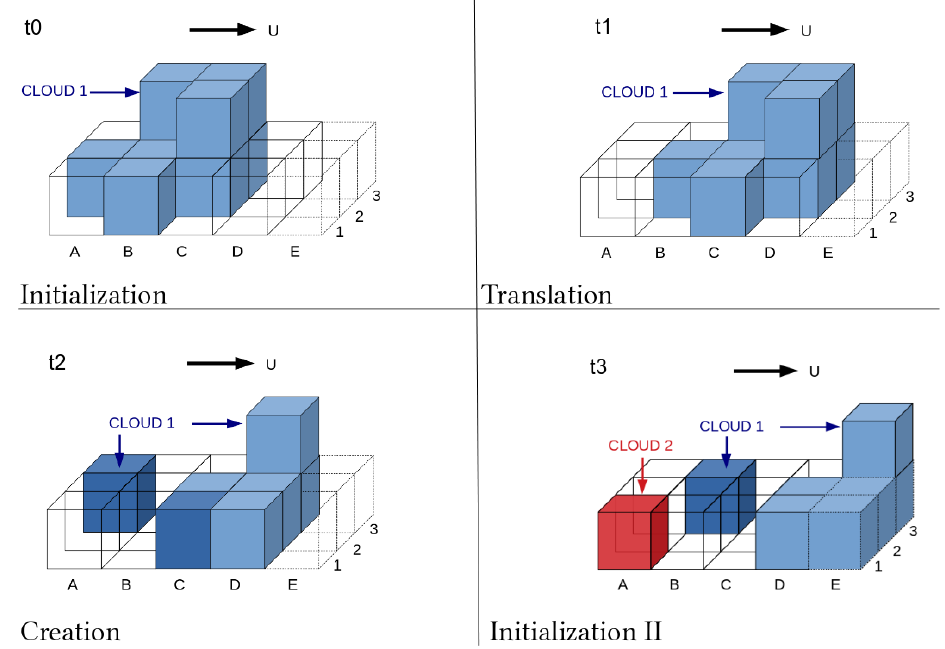
Figure 2. Scheme of temporal cloud identification method for following a cloud in a dynamic